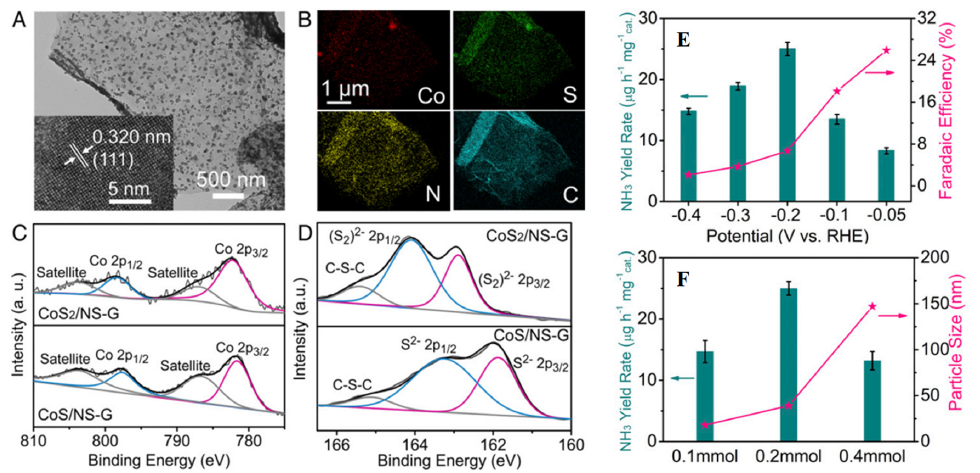
Figure 6. CoSx/NS ‐ G hybrids composite characterization. ( A ) TEM and HRTEM images of CoS 2 /NS ‐ Figure 6. CoSx/NS-G hybrids composite characterization. ( A ) TEM and HRTEM images of CoS 2 /NS- G. ( B ) CoS 2 ‐ doped NS ‐ G hybrid composite elemental mapping images. XPS spectrum of Co 2p (C) G. ( B ) CoS 2 -doped NS-G hybrid composite elemental mapping images. XPS spectrum of Co 2p andS 2p ( D ) for the CoS/NS ‐ G and CoS 2 /NS ‐ G hybrid products. (E) NH 3 yield rate and Faradaic ( C ) andS 2p ( D ) for the CoS/NS-G and CoS 2 /NS-G hybrid products. ( E ) NH 3 yield rate and Faradaic efficiency of CoS 2 /NS ‐ G at each given potential. (F) Comparison of NH 3 yield rate at − 0.2 V and efficiency of CoS 2 /NS-G at each given potential. ( F ) Comparison of NH 3 yield rate at − 0.2 V and particle size for CoS 2 /NS ‐ G hybrids which was synthesized by different amounts of cobalt salt. [47]. particle size for CoS 2 /NS-G hybrids which was synthesized by different amounts of cobalt salt. [47]. (iii) Recombination with 1D nanomaterials (nanorods) (iii) Recombination with 1D nanomaterials